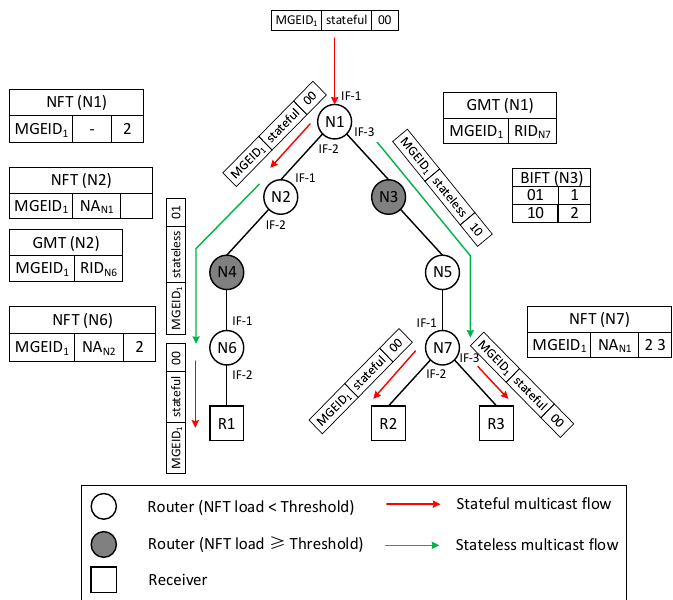
Figure 7. The example of the data forwarding process in AHHM.